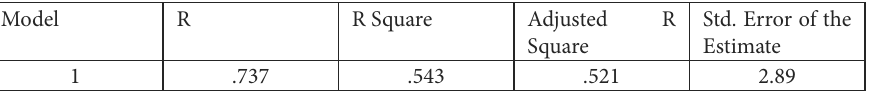
Tab. 13. Predictors of the tendency to leave the organization for the respondents under 35 years. Model summary.